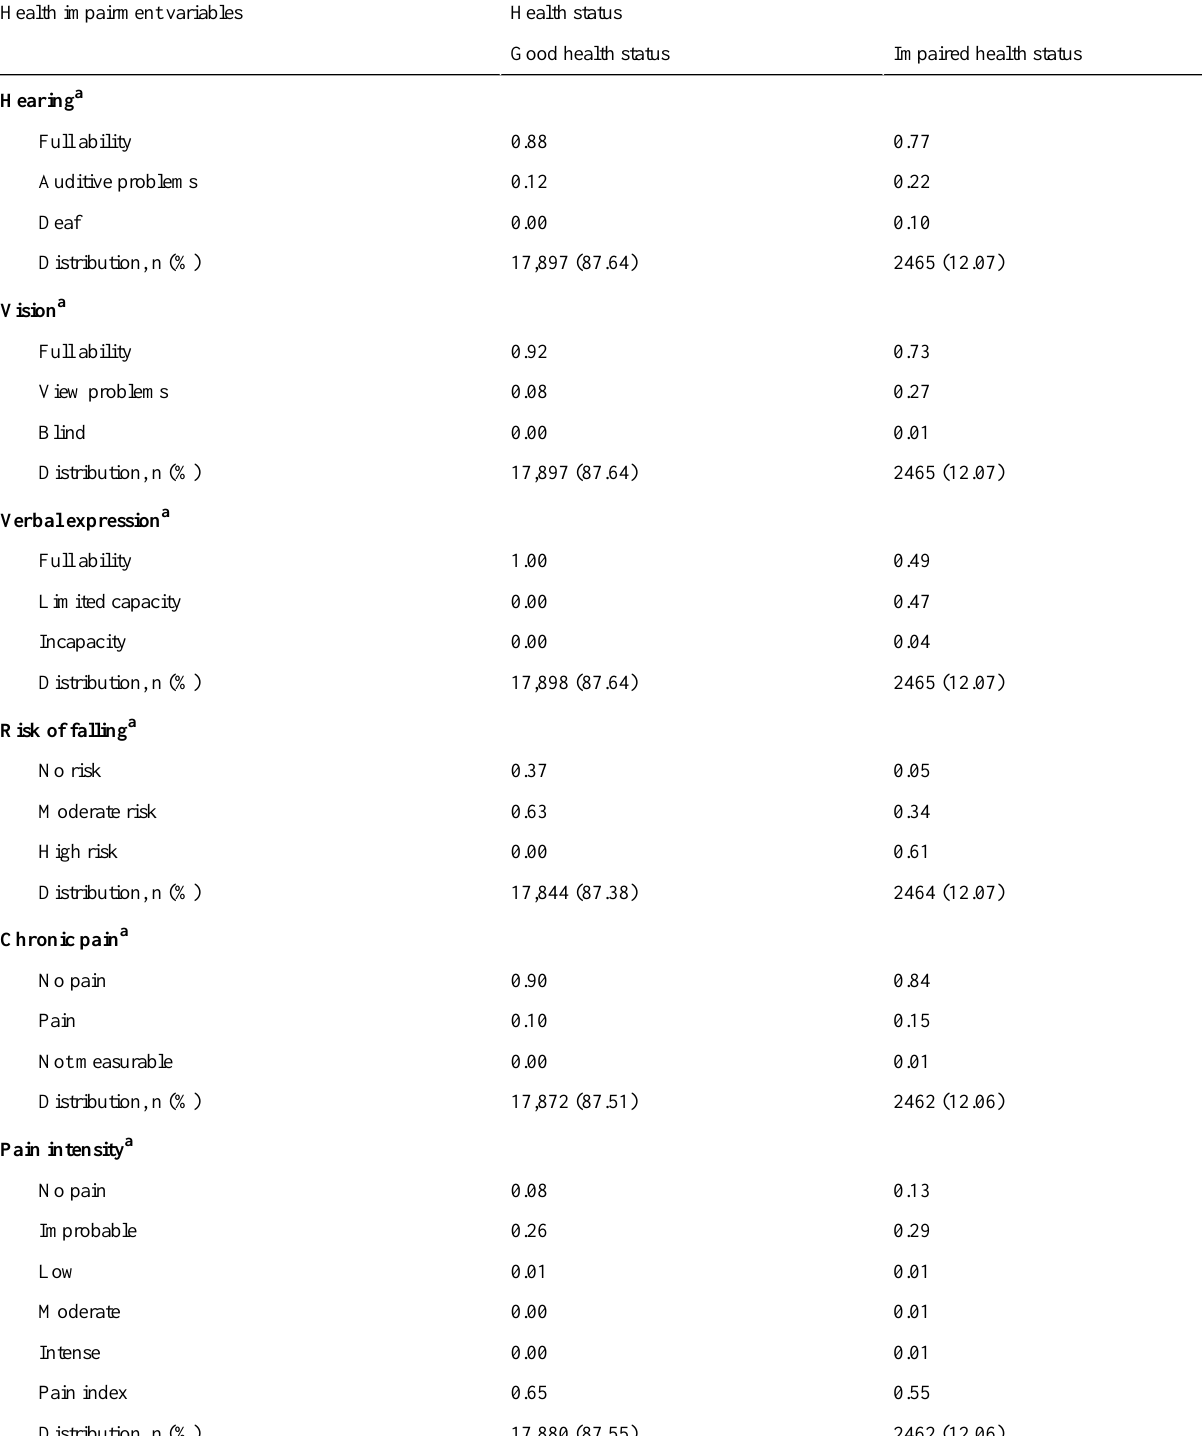
Table 4. Distribution of individuals in the 2-cluster solution for all health impairment variables